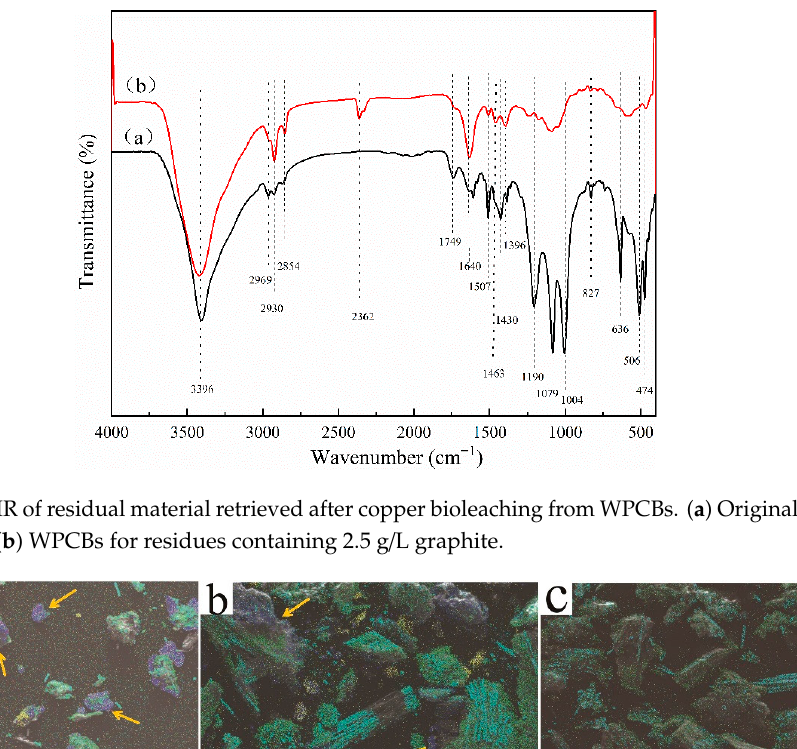
8 of 10 Figure 8. Copper-leaching percentage (mean ± SD) during WPCB bioleaching at different graphite concentrations (other conditions: 1.6 pH, 2% ( w / v ) pulp density, 45 °C, 170 rpm). As observed in Figure 8, a 10% increase in the copper leaching was recorded by adding 0.5 g graphite to the system. In order to study the action mechanism of graphite, leaching residues were analyzed by infrared spectroscopy and scanning electron microscopy for assays with a graphite addition of 2.5 g/L. The FT-IR spectra of the residual materials retrieved from the bioleaching bath with and without the involvement of graphite are shown in Figure 9, in which peak absorption frequencies associated with chemical bonds or functional groups can also be seen. The absorption peak at 3396 cm − 1 belongs to the stretching vibration of O–H. Antisymmetric and symmetric stretching vibrations of − CH 2 appeared at 2930 and 2854 cm − 1 , respectively. C=O stretching vibrations for carboxyl and carbonyl groups appeared at 1720 cm − 1 . The bending vibration of water molecule − OH was located at 1640 cm − 1 , and the stretching vibration of C=C at 1507 cm − 1 . The FTIR spectrum of the residual WPCB